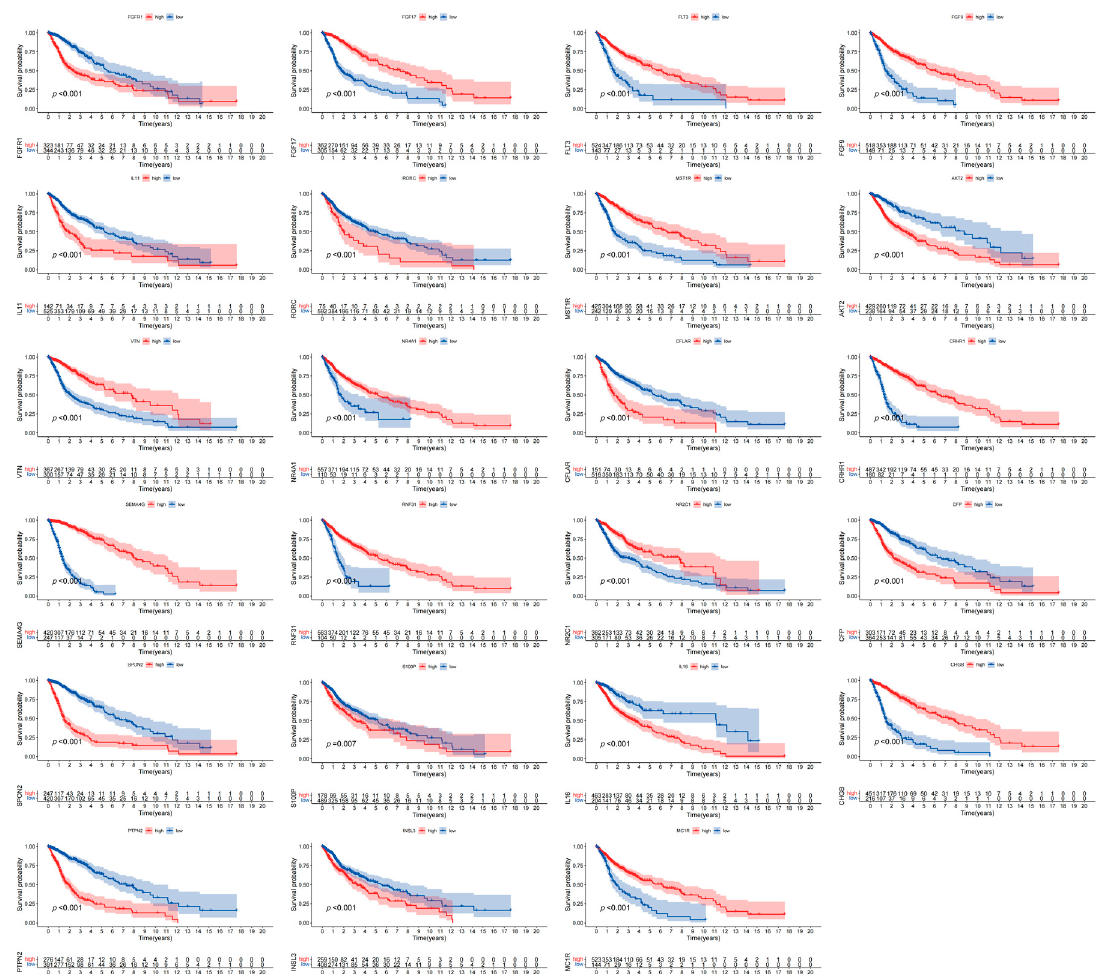
Figure A2. Kaplan–Meier curves of 23 hub genes related to the OS of glioma patients.